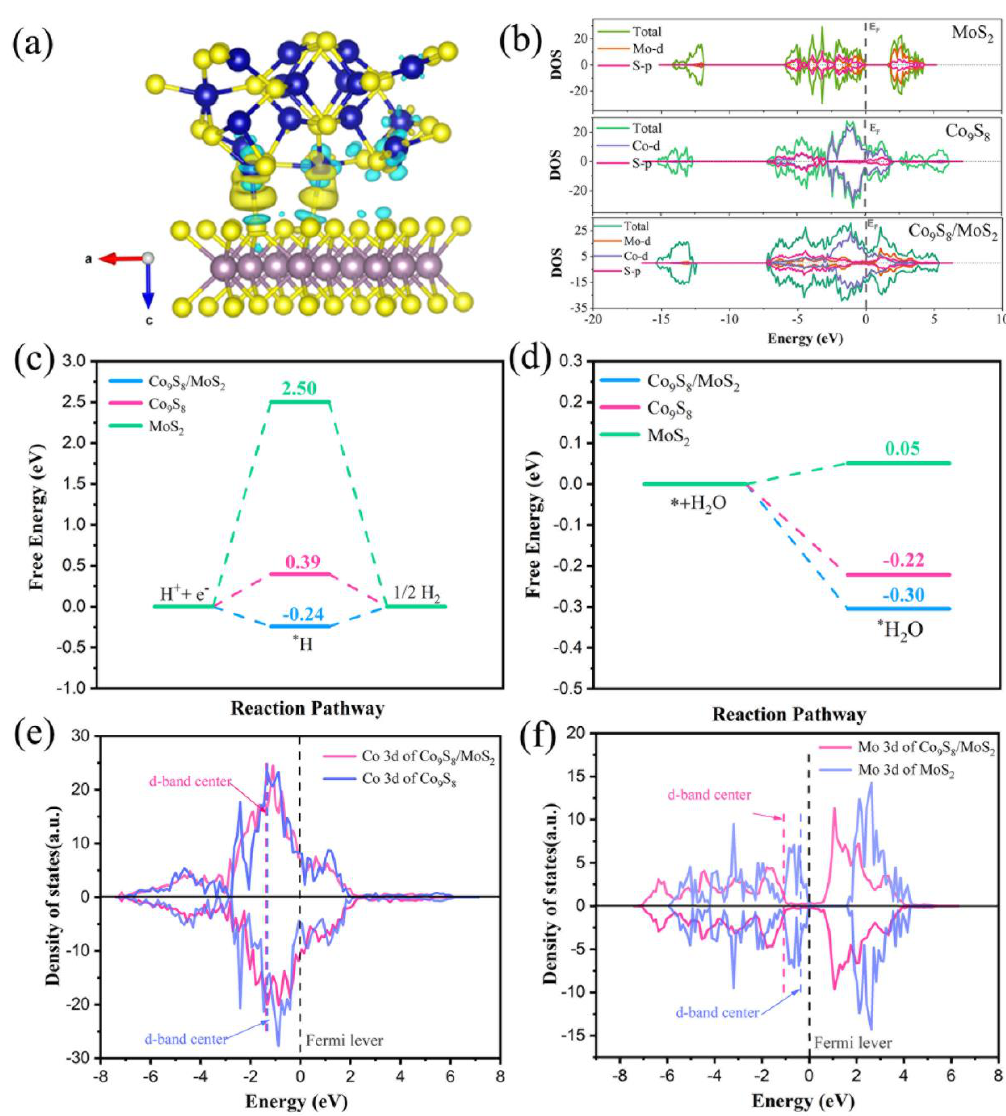
Figure 11. ( a ) Charge density difference for the Co 9 S 8 /MoS 2 heterointerface with the iso-surface value of the color region being 0.0005 e Å −3 . The yellow and blue colors indicate the positive and negative charges, respectively. Blue balls represent Co atoms, yellow balls represent S atoms, and brown balls represent Mo atoms. ( b ) DOS curves; ( c ) calculated ΔG H* for the HER; ( d ) calculated water adsorption energy; ( e ) PDOS of Co for Co 9 S 8 and Co 9 S 8 /MoS 2 ; ( f ) PDOS of Mo for MoS 2 and Co 9 S 8 /MoS 2 .